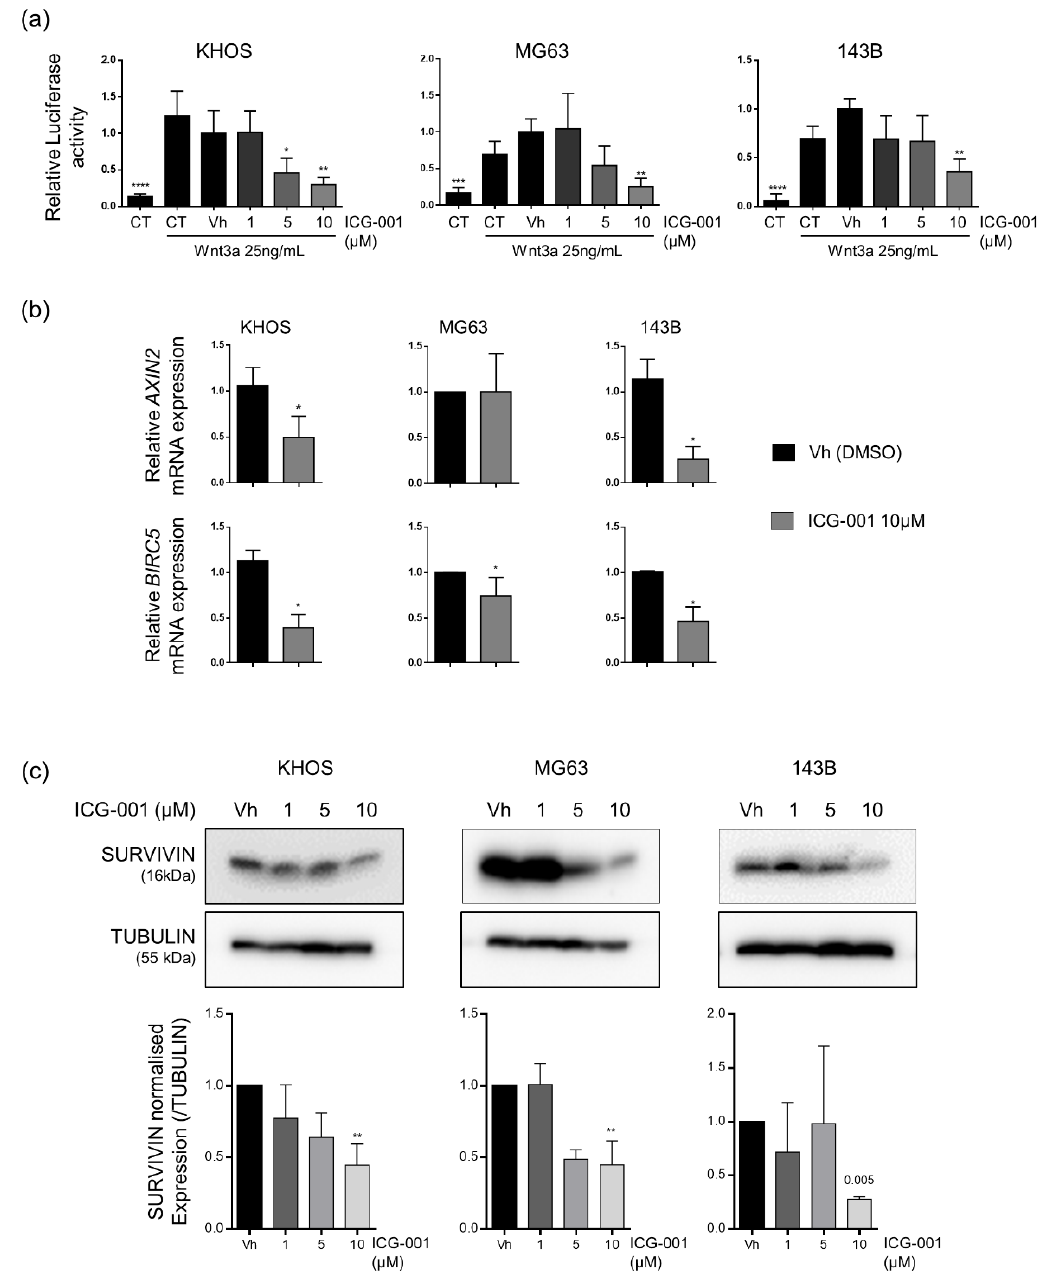
Figure 2. ICG-001 inhibits β -catenin dependent transcription in KHOS, MG63 and 143B osteosarcoma cell lines. ( a ) Relative Luciferase Firefly/Renilla activity ratio in cells co-transfected with TOPFLASH and pRL-TK constructs and treated or not (CT) with vehicle (Vh) or ICG-001 (1 to 10 µ M). Wnt3a 25 ng/mL was added 1 h after ICG-001 treatment for a period of 24 h. Bars represent means ± SD of 5 independent experiments. * p < 0.05; ** p < 0.01; *** p < 0.001; **** p < 0.0001 vs. vehicle. ( b ) Relative and normalized AXIN2 or BIRC5 gene expression determined by RT-qPCR in cells treated with vehicle (Vh) or 10 µ M of ICG-001 during 24 h (right panel). Bars represent means ± SD ( n = 3, performed in duplicate). * p < 0.05 vs. vehicle. ( c ) SURVIVIN and TUBULIN protein level evaluated by western blot in cells treated with vehicle (Vh) or ICG-001 (1–10 µ M) during 48 h (upper panel with one representative experiment of three independent experiments). Relative SURVIVIN protein quantification, normalized with TUBULIN protein expression (lower panel). Bars indicate means ± SD of three independent experiments. ** p < 0.01 vs. vehicle.